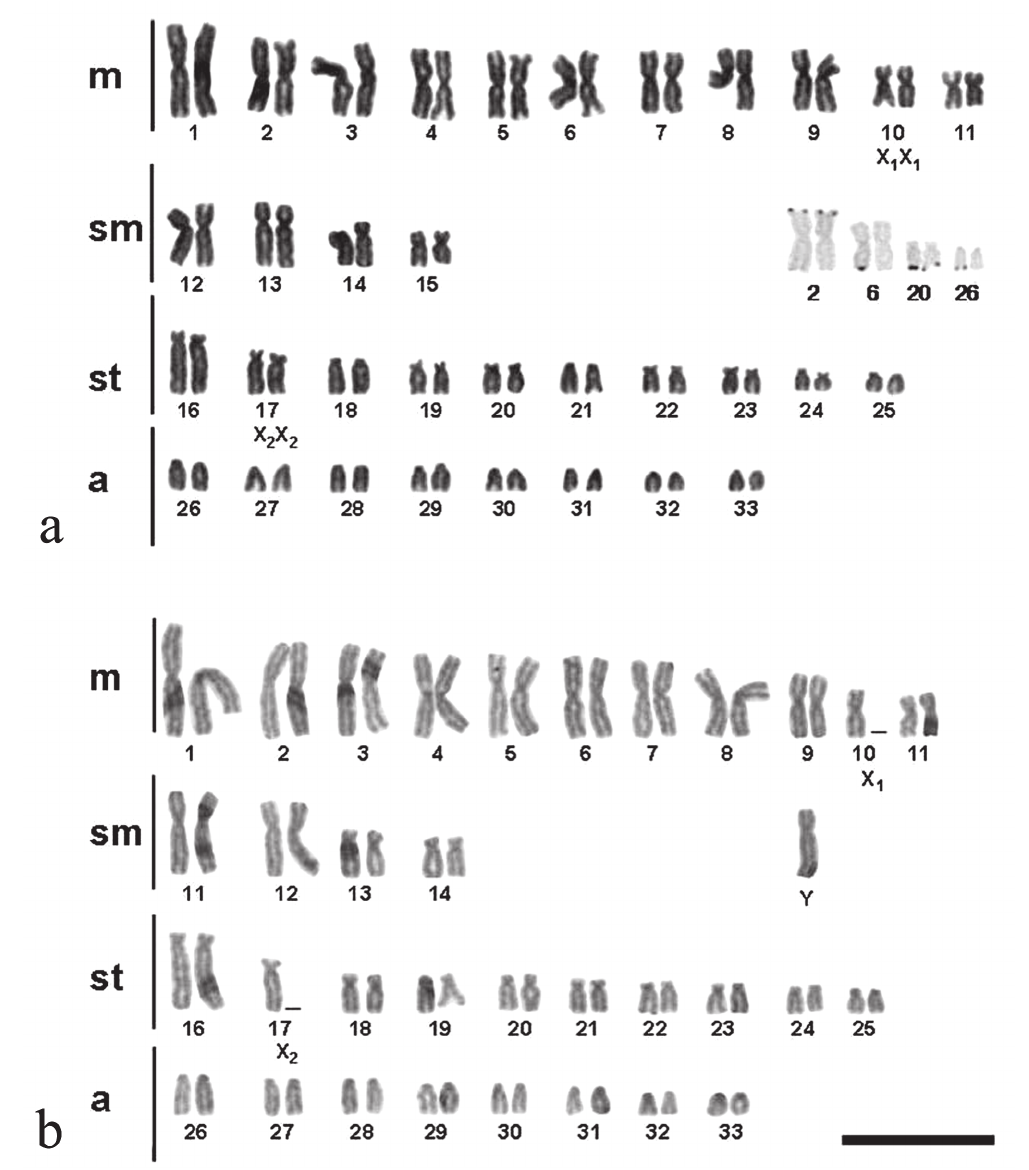
Fig. 3. Karyotypes of female ( a ) and male ( b ) of Potamotrygon aff. motoro sample from Ilha Solteira, highlighting the sex chromosomes after conventional and the chromosomes marked by NOR. Scale bar = 10 